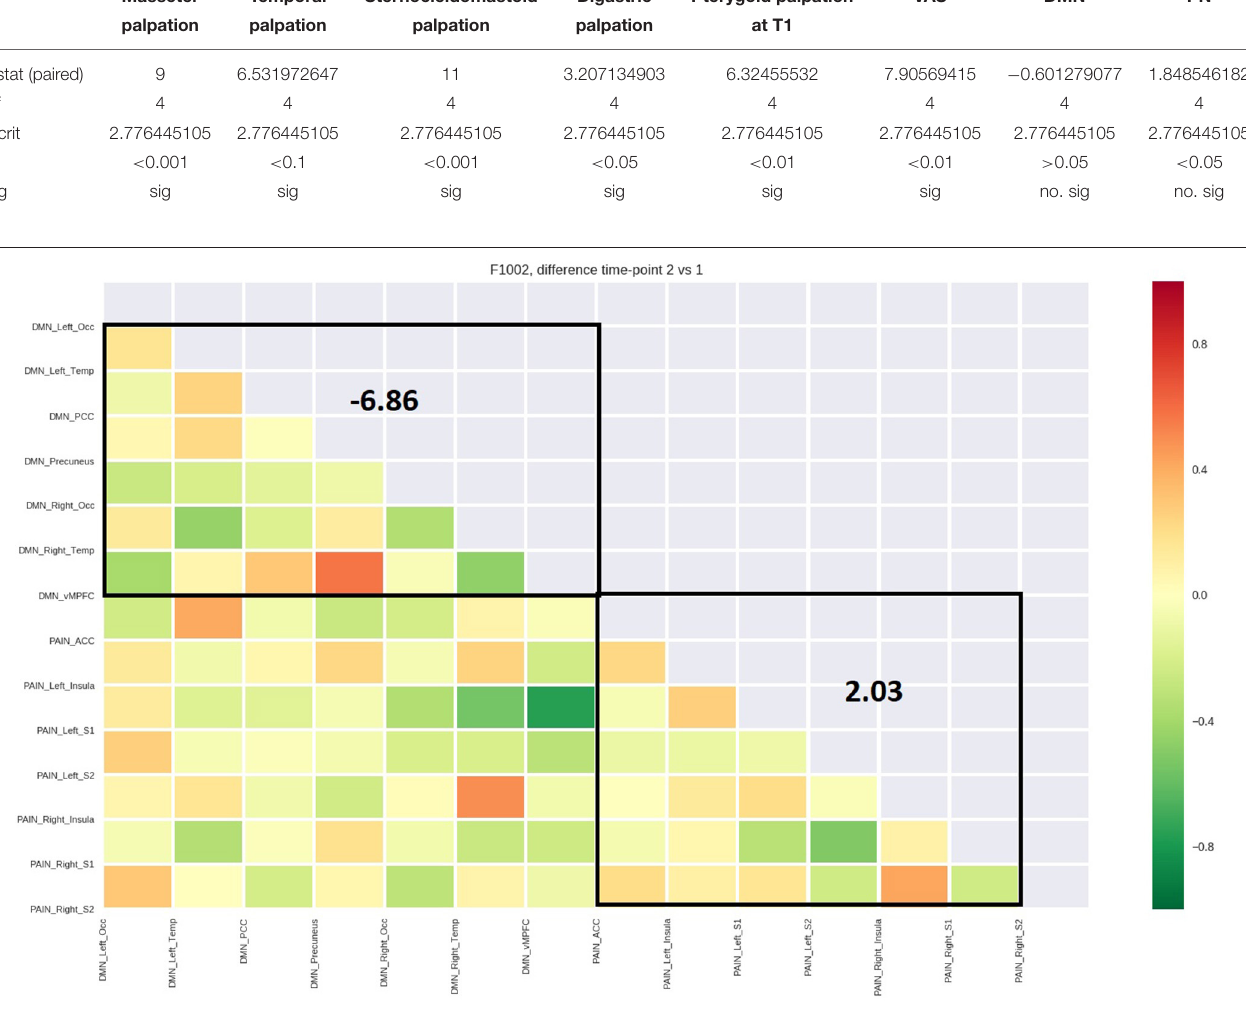
during maximum contraction. The patient visualized the muscle’s volume in a mirror as a swollen tennis ball for 5